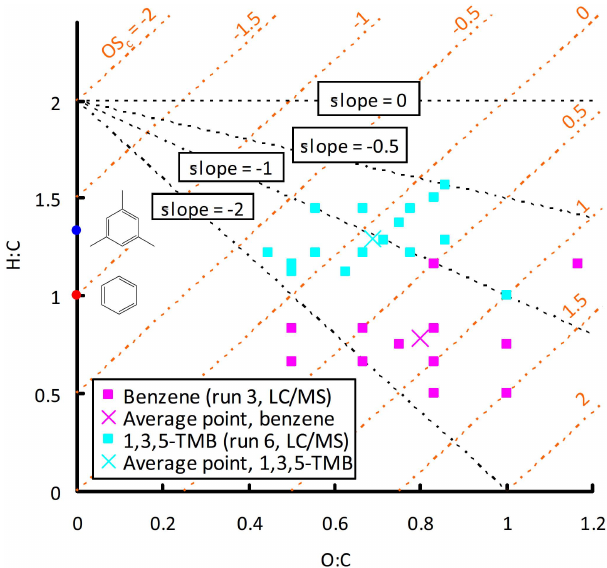
Fig. 2. Van Krevelen diagram of organic molecules identified by off-line LC/TOF-MS analysis of SOA from the photooxidation of aromatic hydrocarbons in the presence of NO x